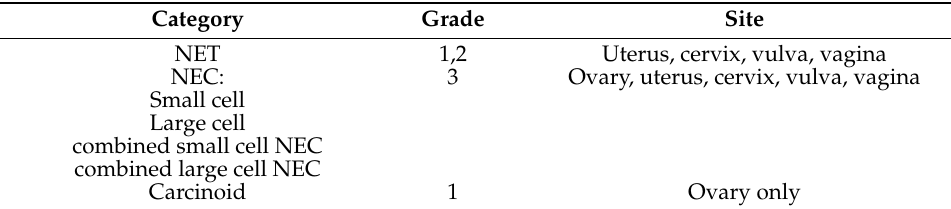
Table 1. WHO terminology for NEN of gynecologic tract, fifth edition. Category